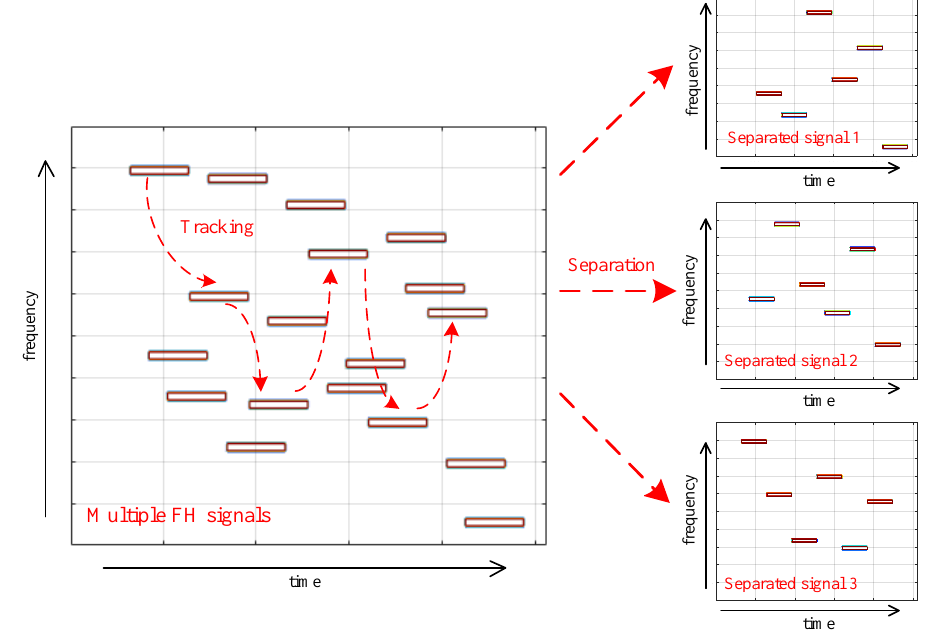
Figure 1. Sketch of tracking and separation of frequency hopping (FH) signal.